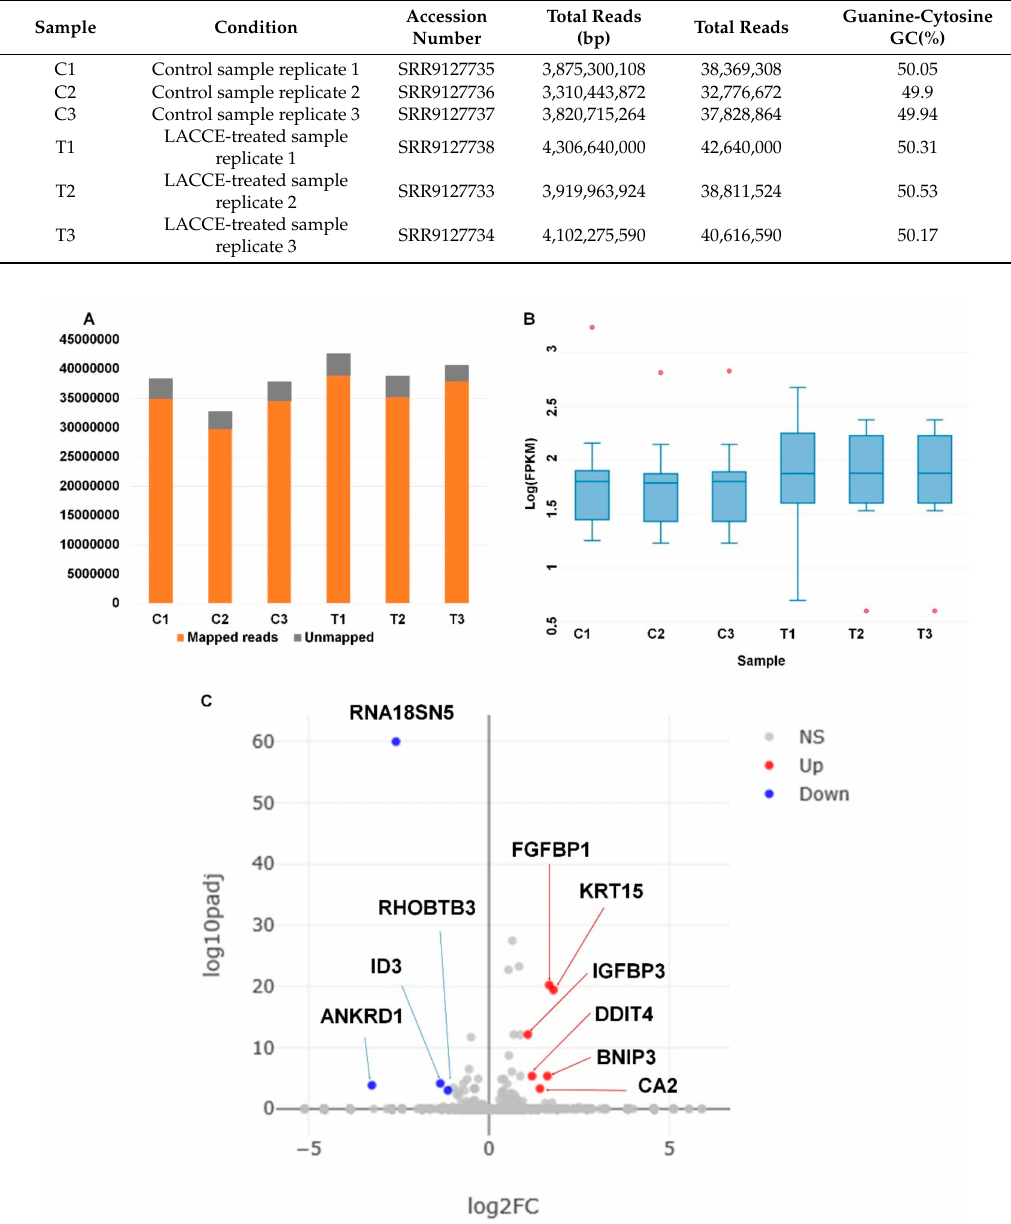
Figure 5. Mapping results, distribution of fragments per kilobase of transcript per million (FPKM) values, and visualization of di ff erentially-expressed genes. ( A ) Portion of mapped (orange) and unmapped (gray) reads on human reference transcriptome. ( B ) Boxplot showing distribution of FPKM values in each library. ( C ) Volcano plot displaying distribution of log 10 (padj) and log 2 (FC) for all expressed genes. Padj and FC indicate adjusted p -value and fold change, respectively. Ten identified DEGs are indicated with blue (down-regulated genes, Down), red (up-regulated genes, Up), and gray (not significantly expressed genes, NS)